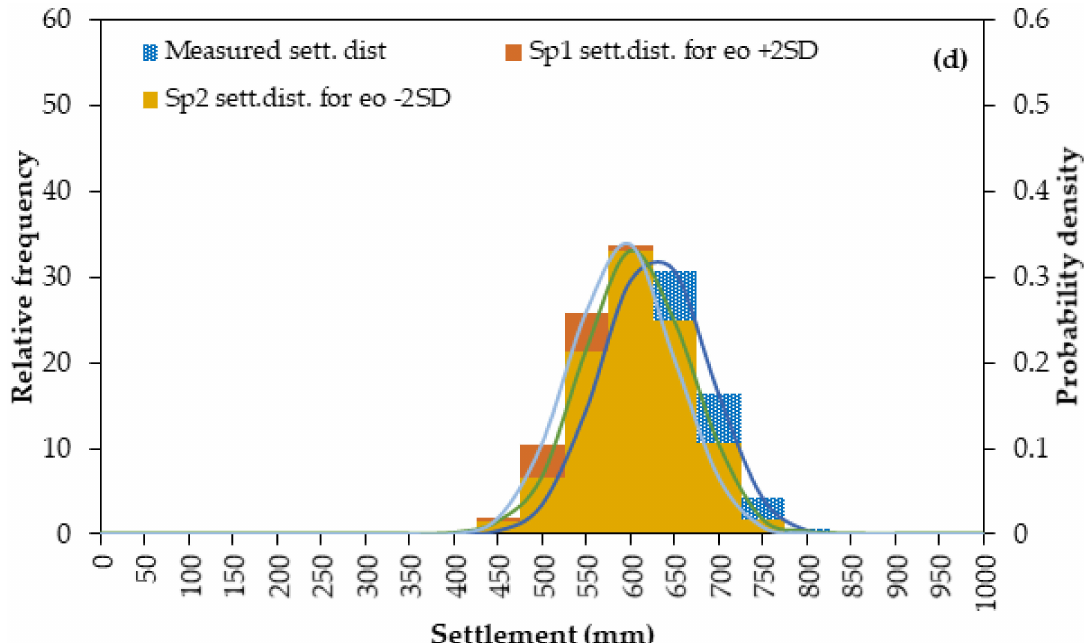
Figure 12. Uncertainty distribution of ultimate consolidation settlement for ( a ) C c ( b ) k v ( c ) C α and ( d ) e o –Karakore site.